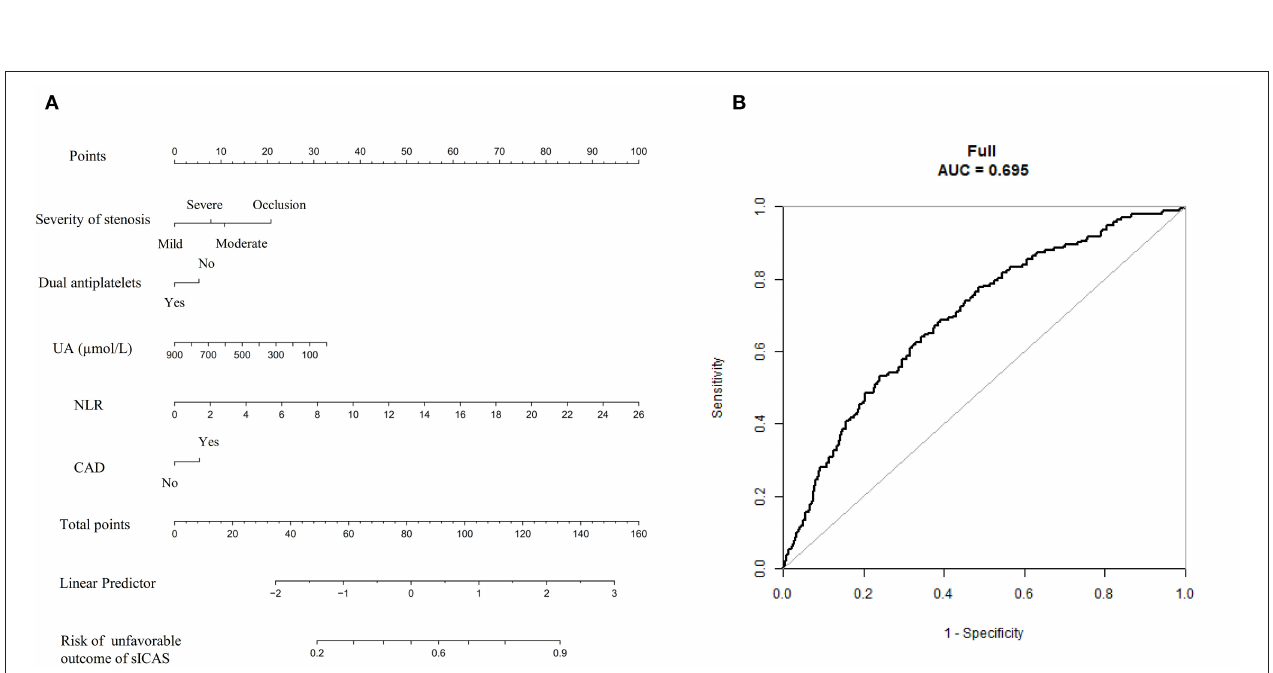
FIGURE 6 | The nomogram for predicting the short-term prognosis of sICAS patients. (A) The nomogram for predicting the risk of unfavorable short-term outcome of sICAS patients. (B) The ROC curve of the nomogram. The predictors were chosen based on the results of multivariate logistic regression in Model 1. Each selected factor was shown by a line in the nomograms. sICAS, symptomatic intracranial atherosclerotic stenosis; NLR, neutrophil-to-lymphocyte ratio; UA, uric acid; CAD, coronary artery disease; ROC, receiver operating characteristic; AUC, area under the curve.